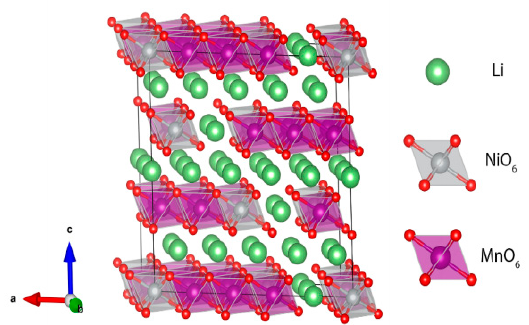
Figure 1. Schematic view of the crystal structure of Li-rich Li 1.2 Ni 0.2 Mn 0.6 O 2 . The red, green, silver, and purple spheres represent O, Li, Ni, and Mn atoms, respectively. Reproduced with permission from [2]. Copyright 2018